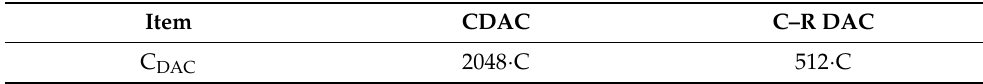
Table 1. Capacitors used in DAC for 11-bit SAR ADC.